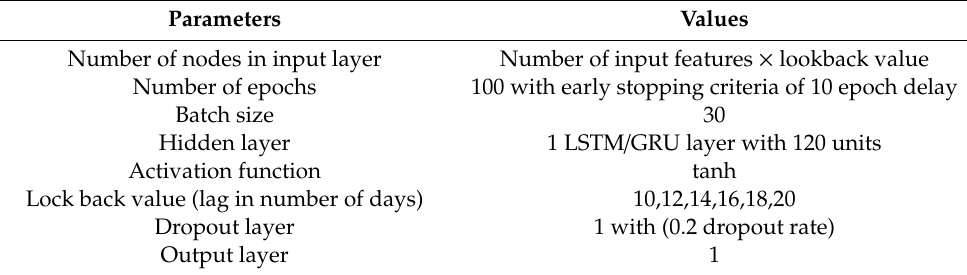
Table 3. Specification of parameters for training.